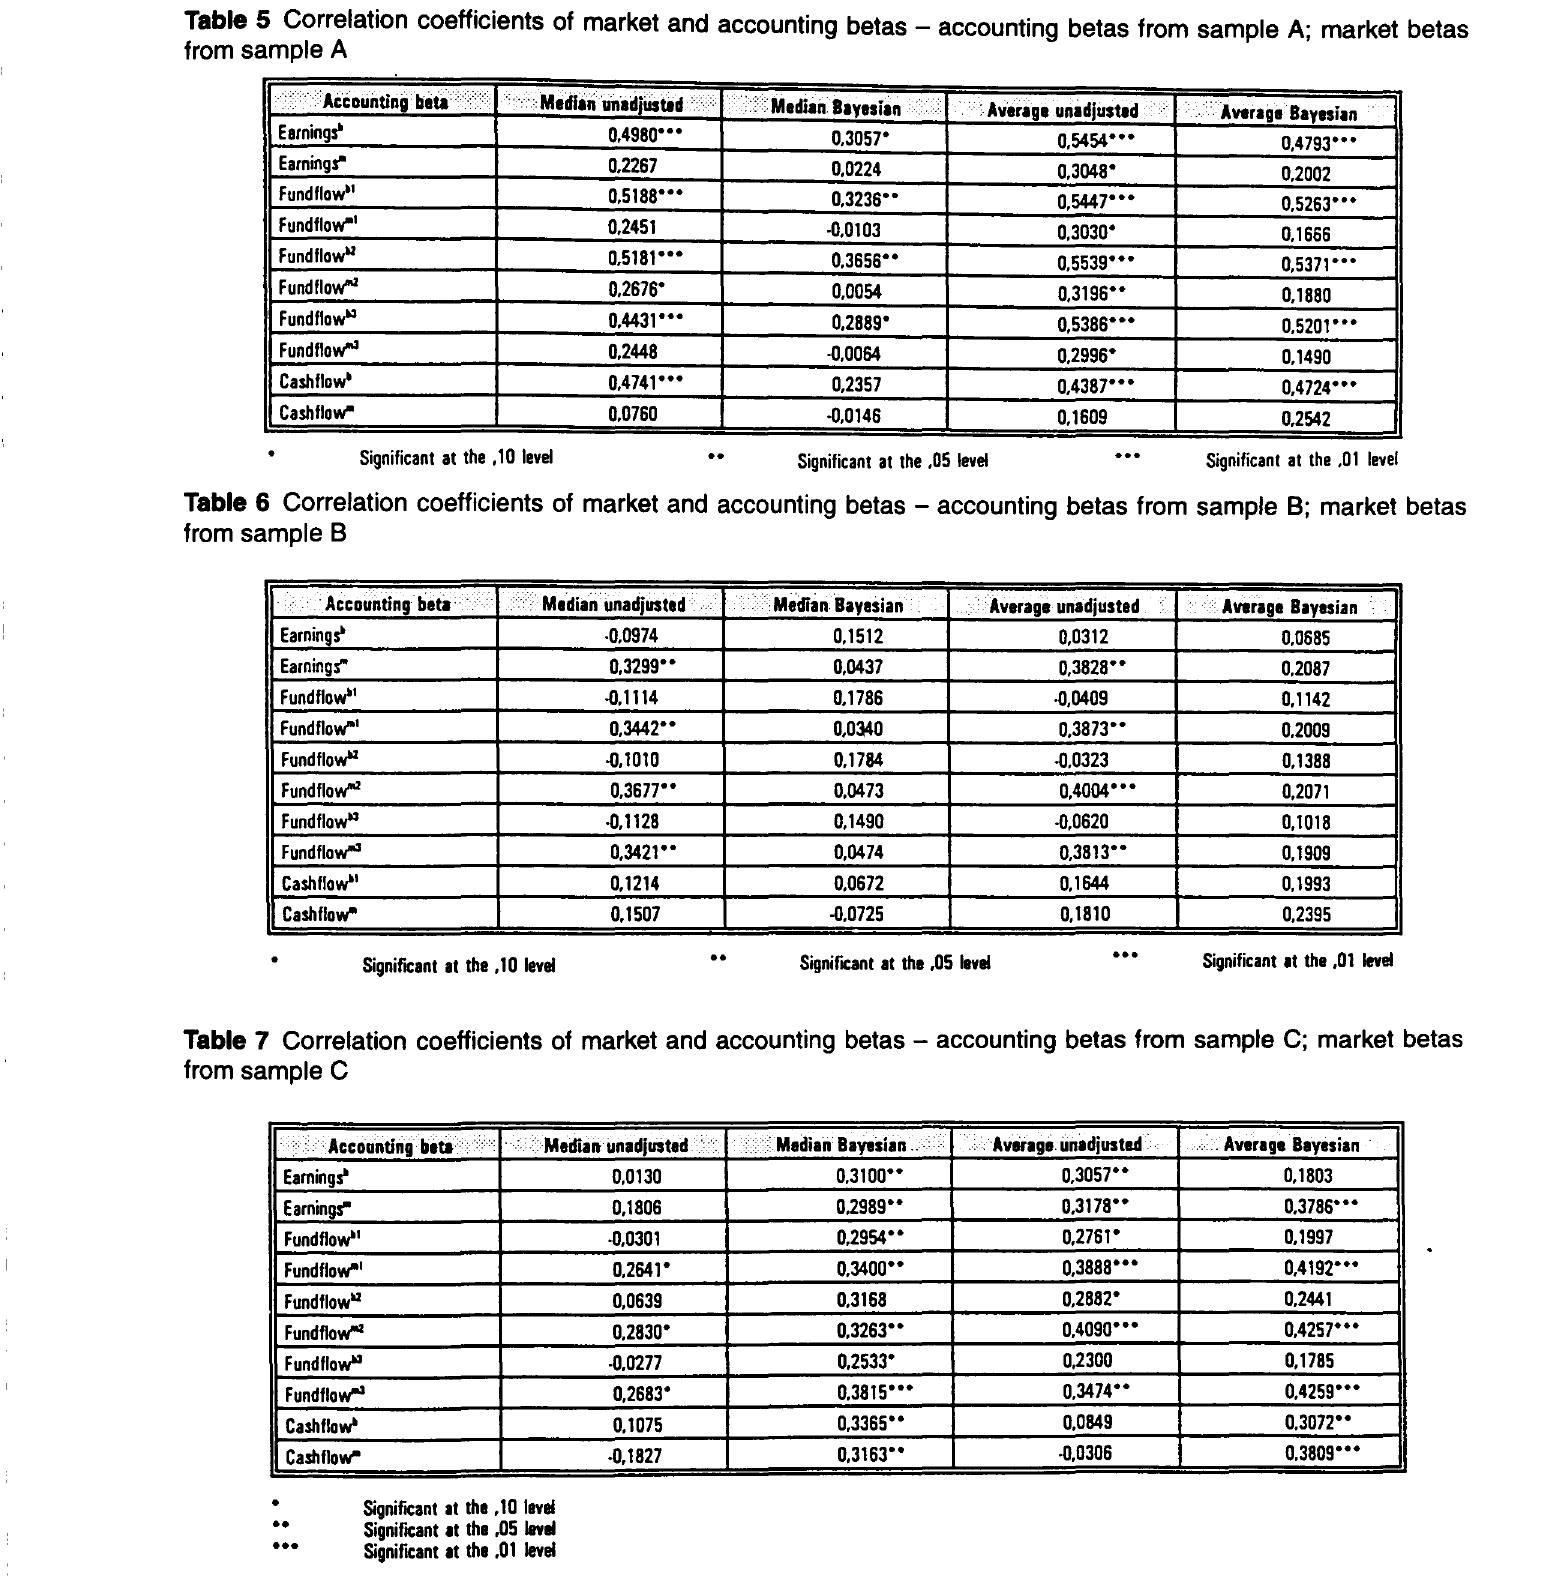
Table 6 Correlation coefficients of market and accounting betas - accounting betas from sample B; market betas from sample B